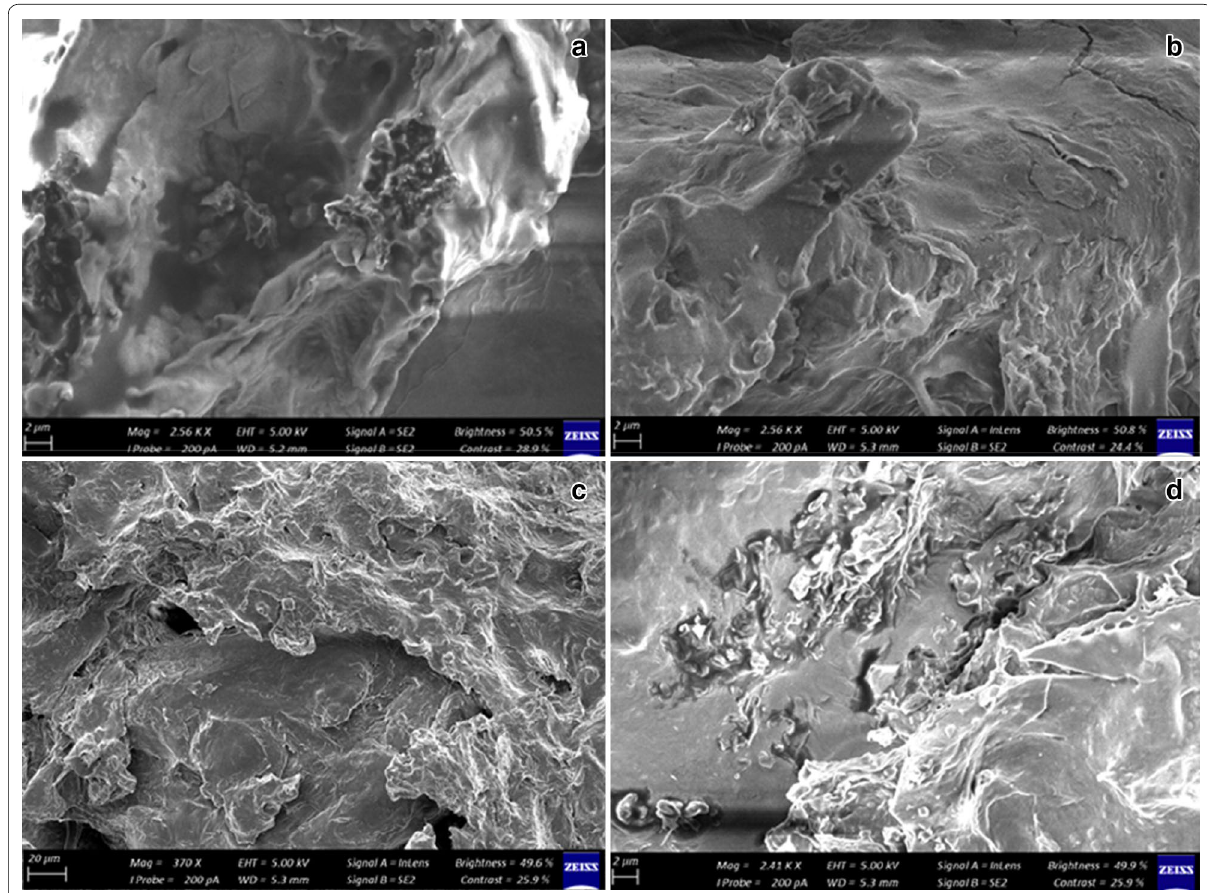
Fig. 7 SEM micrographs of Irvingia‑based wood adhesives, IGN ( a ), IWN ( b ), IGE ( c ), IWE ( d